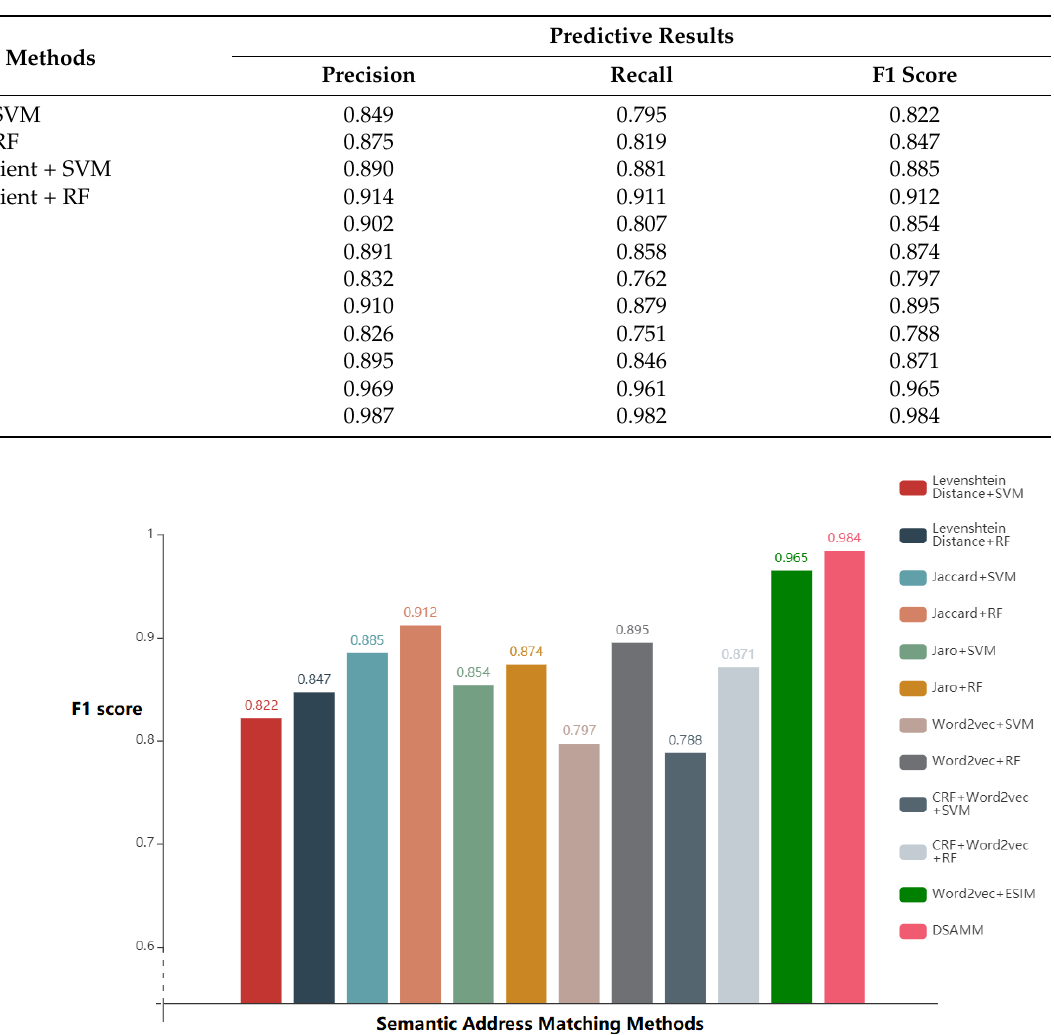
Table 6. Comparative evaluations of different address matching methods in precision, recall, and F1 score.